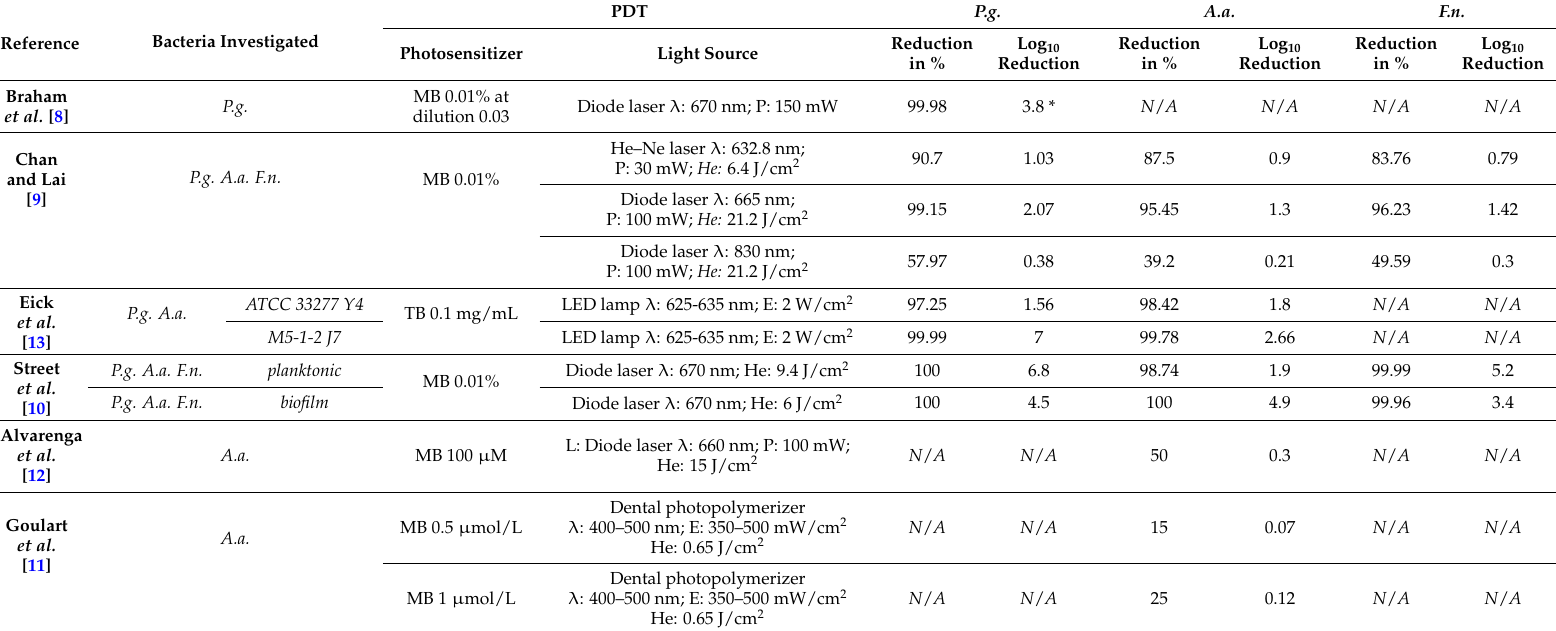
Table 4. Overview of the results (percentage reduction and log reduction) of all included